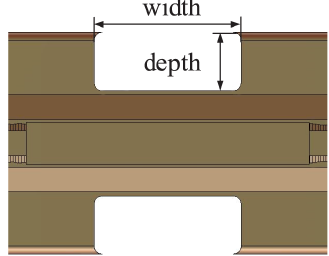
FIG. 8. Parameters of the coupling window.